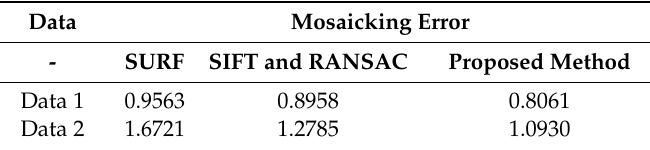
Table 2. Comparison of mosaicking